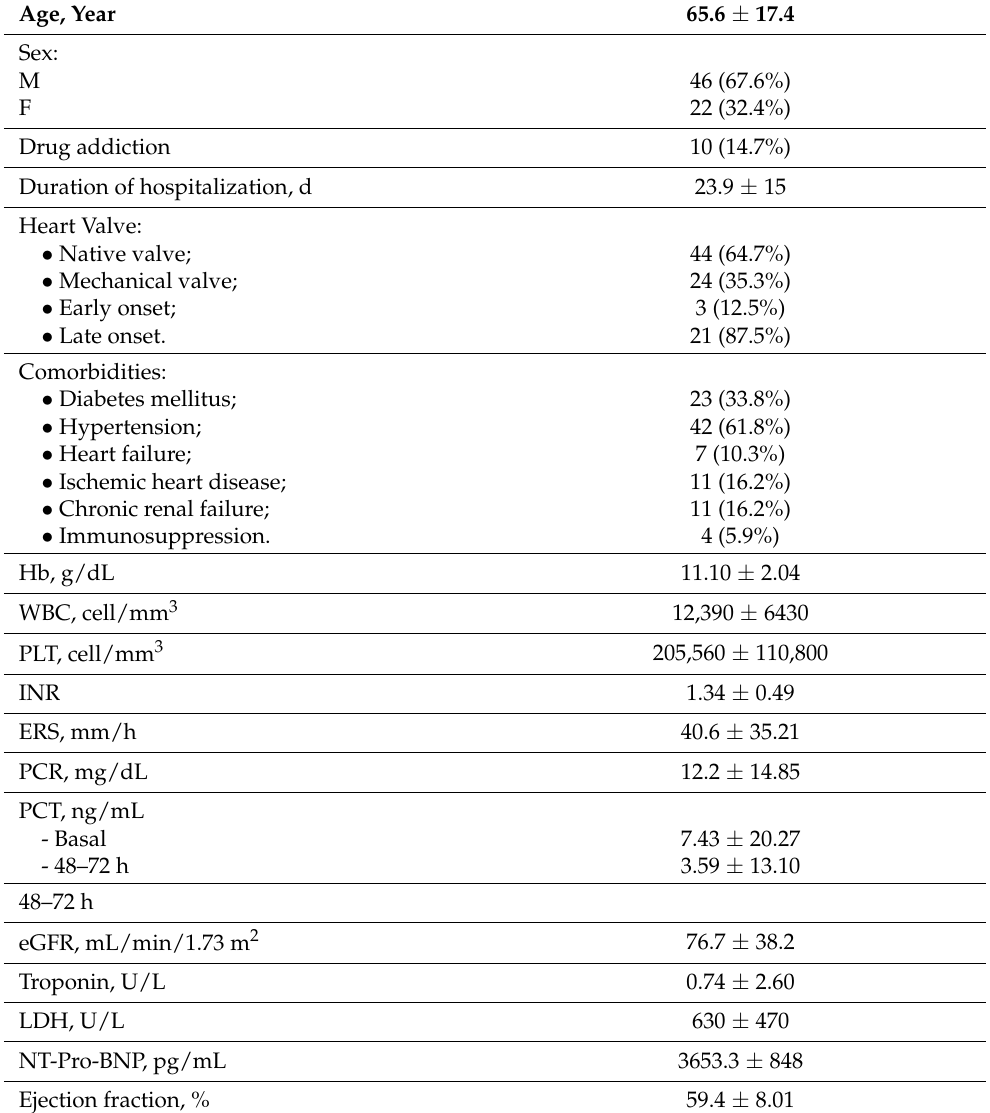
Table 1. Baseline characteristics of 68 patients with infective endocarditis.